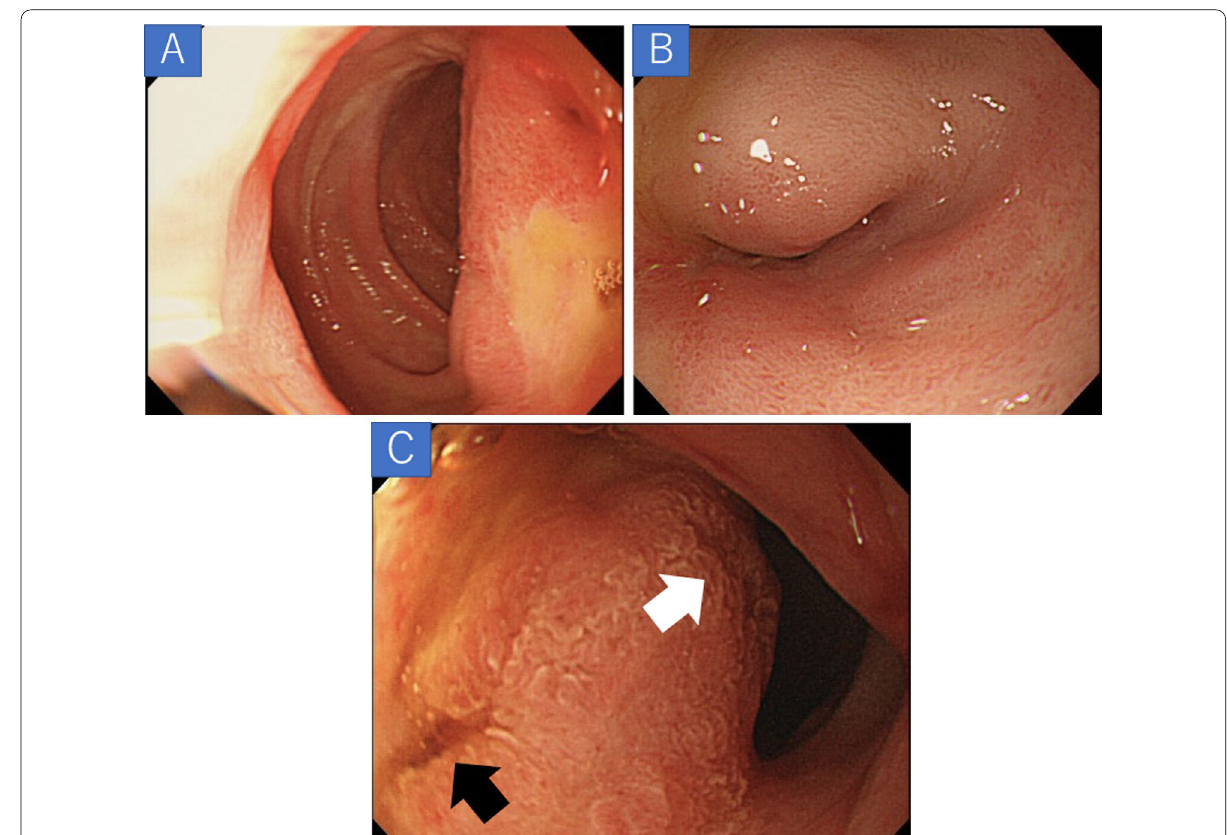
Fig. 1 Endoscopic photograph. A The active duodenal ulcer, proximal to the duodenal stenosis. B The duodenal submucosal tumor at the duodenal bulb. C The papilla of Vater (white arrow) and the small opening with bile excretion (black arrow)